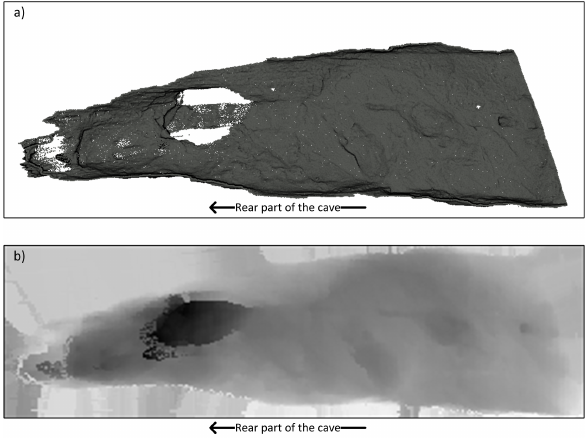
Figure 2. A slice cut from the cave dataset of the right wall: a) point cloud representation; b) raster representation.